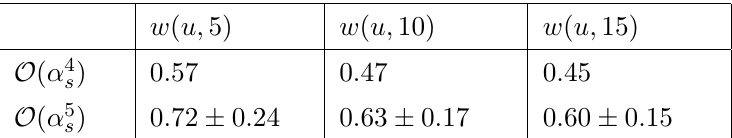
) and O ( α 5 ) . The uncertainties s s